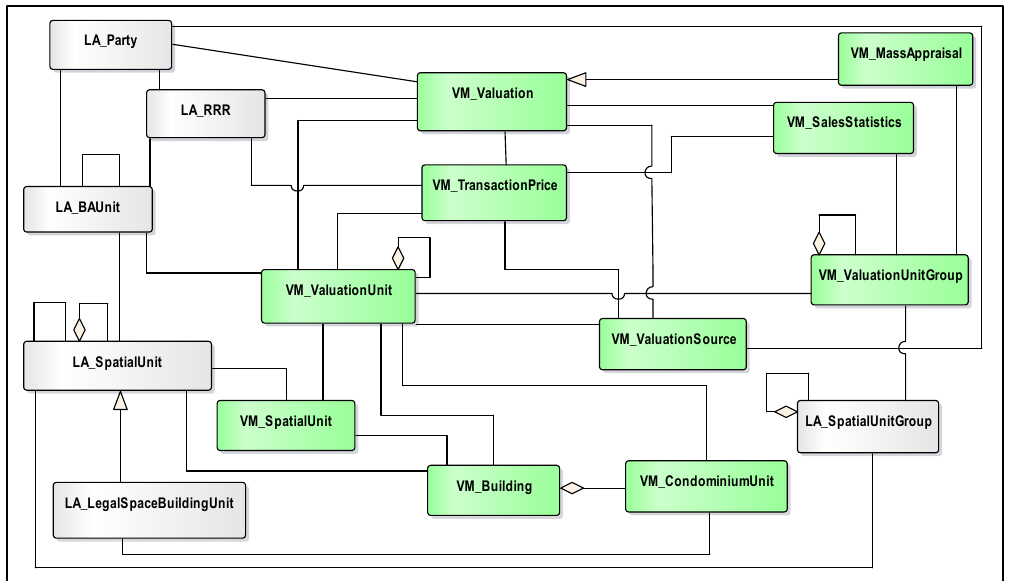
Figure 2. LADM Valuation Information Model and its relationship to LADM I. Adapted from [14].